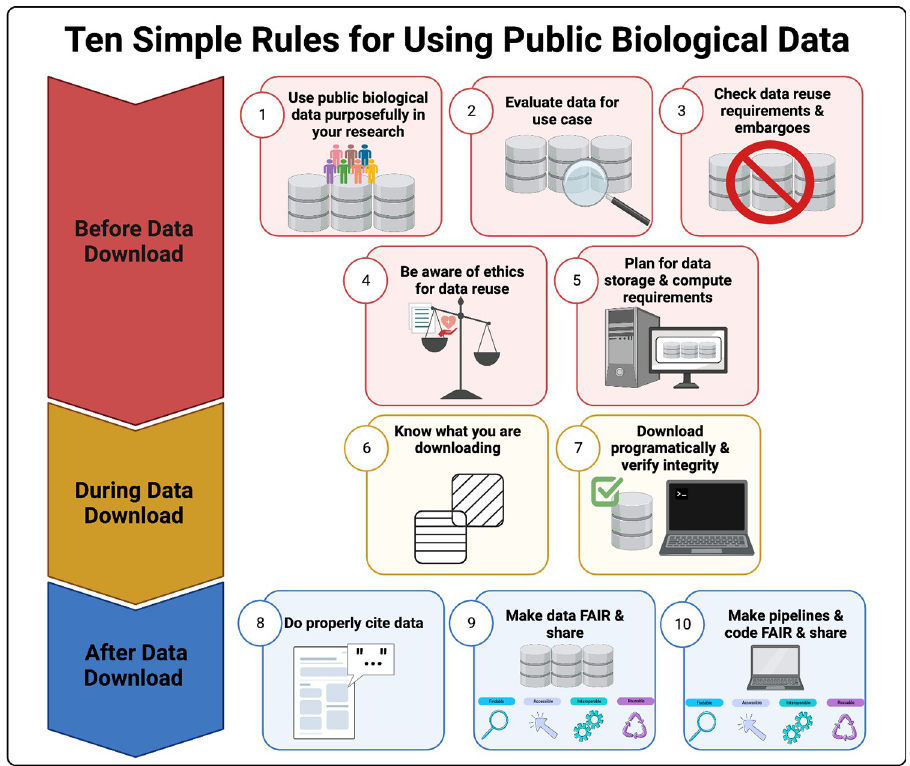
Fig 1. These 10 simple rules for using public data span checklist items for pre, during, and post data